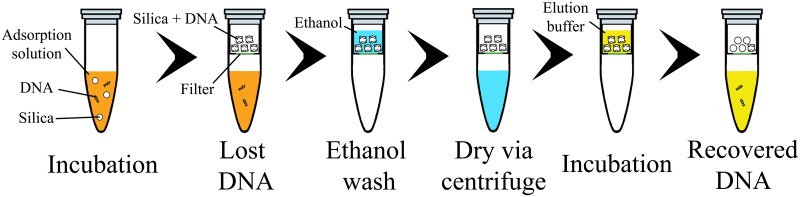
Schematic of general protocol.Silica, adsorption solution, and DNA were combined in a microcentrifuge tube. This solution was incubated for 1 hour in an agitated state to promote mixing. The silica particles and any DNA adsorbed onto them were separated from solution using a filter. The supernatant was analyzed to determine the ‘Lost DNA’ (DNA amount not adsorbed after incubation). The particles were subsequently washed with 70% ethanol and dried. The elution buffer was then added and incubated for 5 min before it was also collected to determine the ‘Recovered DNA’ (DNA amount eluted from the silica surface.